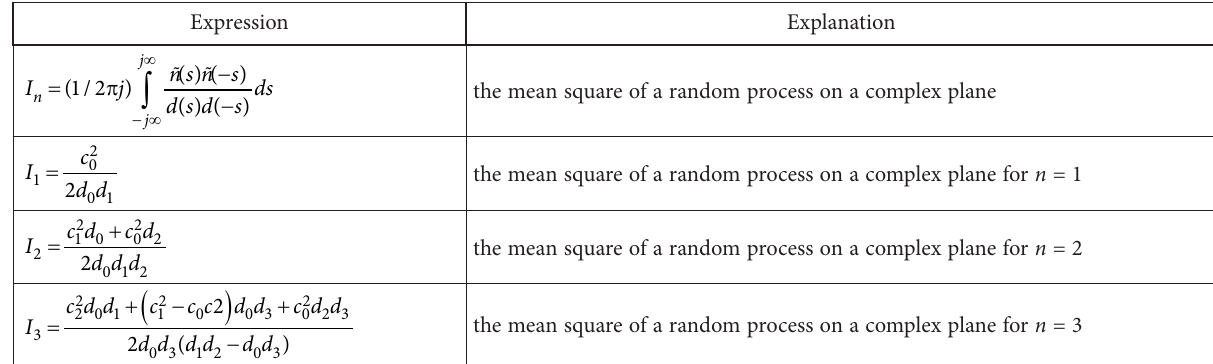
Table 1. Integrals (the relationship between the mean square of a random process and the spectral density) Expression